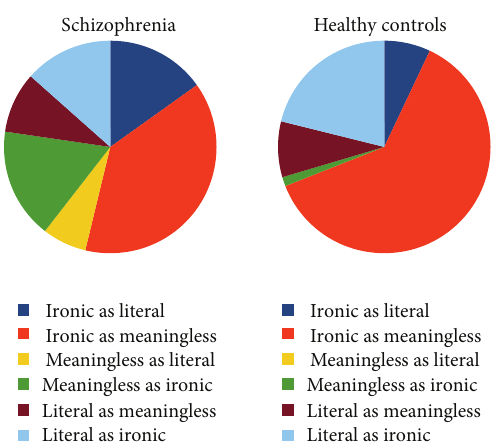
Figure 1: Pattern of errors in the irony comprehension test of patients (left) and control subjects